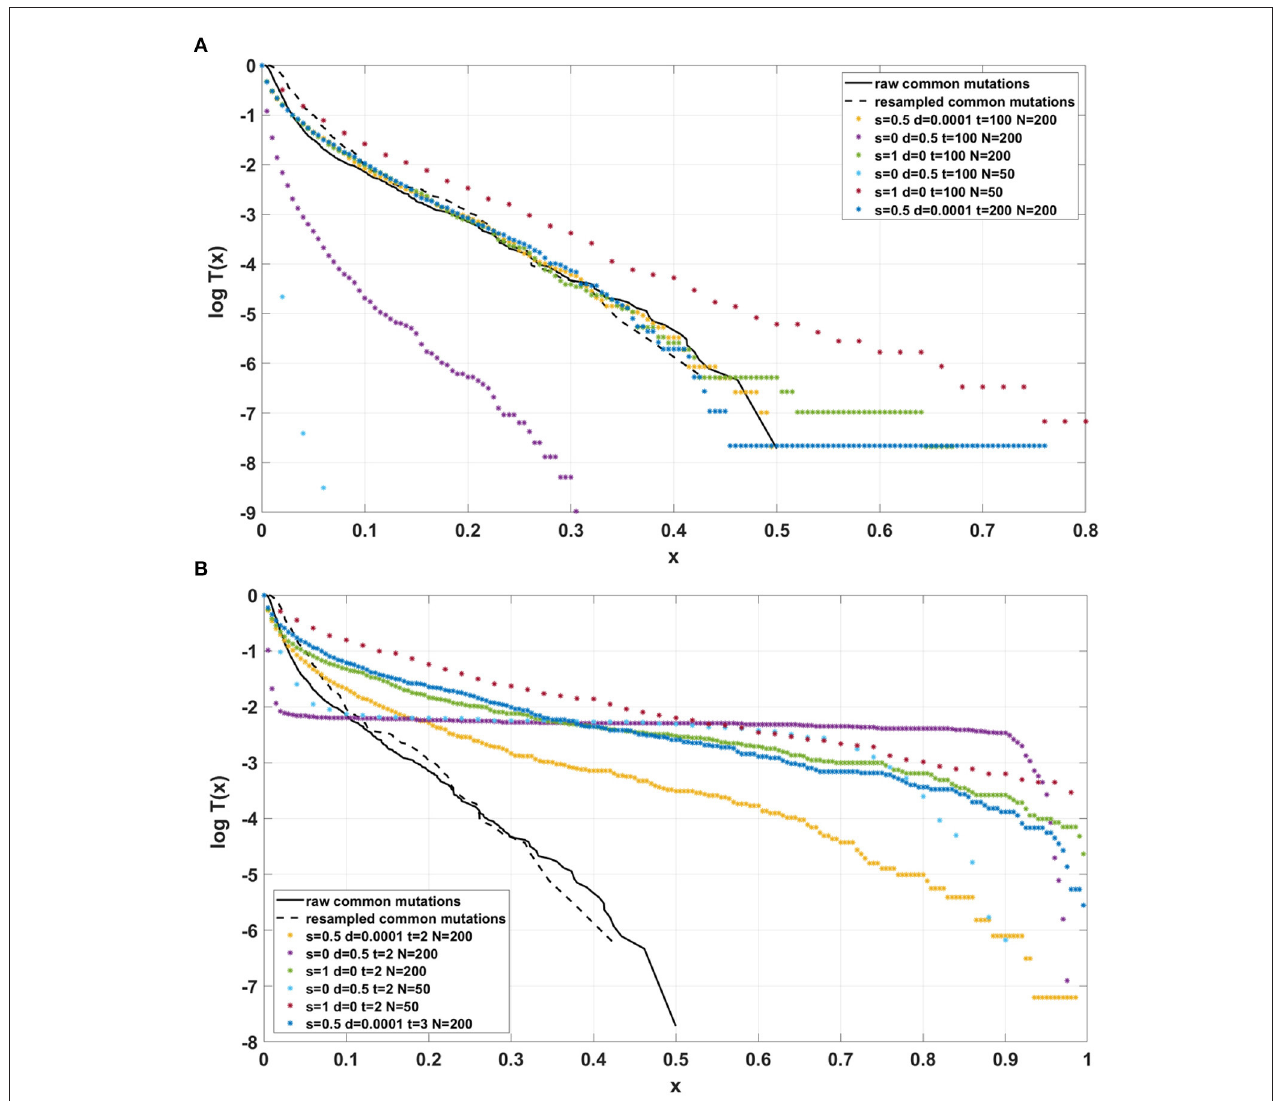
FIGURE 13 | Comparison of semi-logarithmic cumulative tails of the SFS obtained for experimental data from patient G30 with average from 100 simulations with parameters L = N µ = 6 and p = 0.01. (A) Model A; (B) Model B.